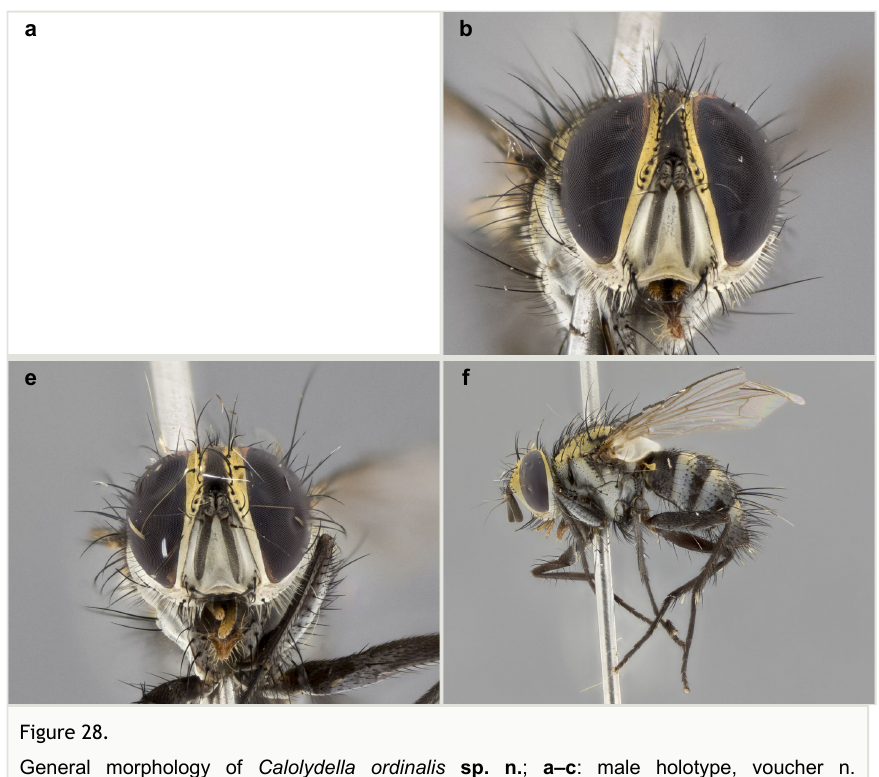
General morphology of Calolydella ordinalis sp. n. ; a–c : male holotype, voucher